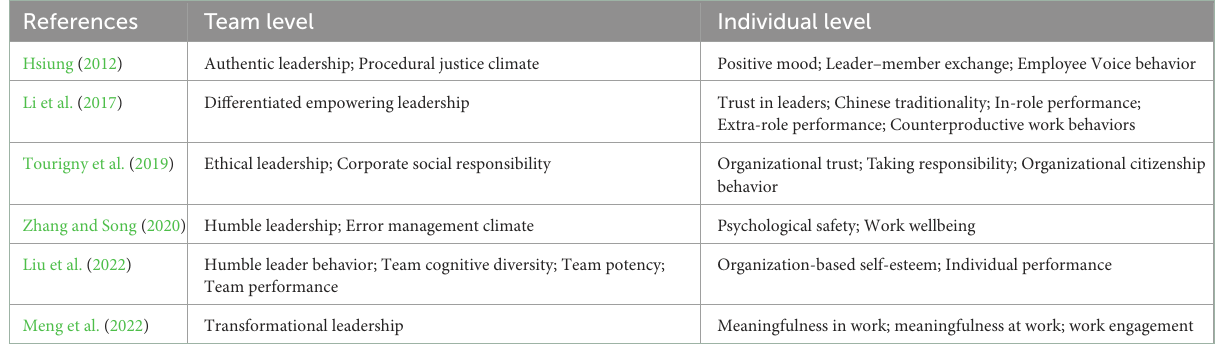
TABLE 1 Relevant previous studies adopted HLM